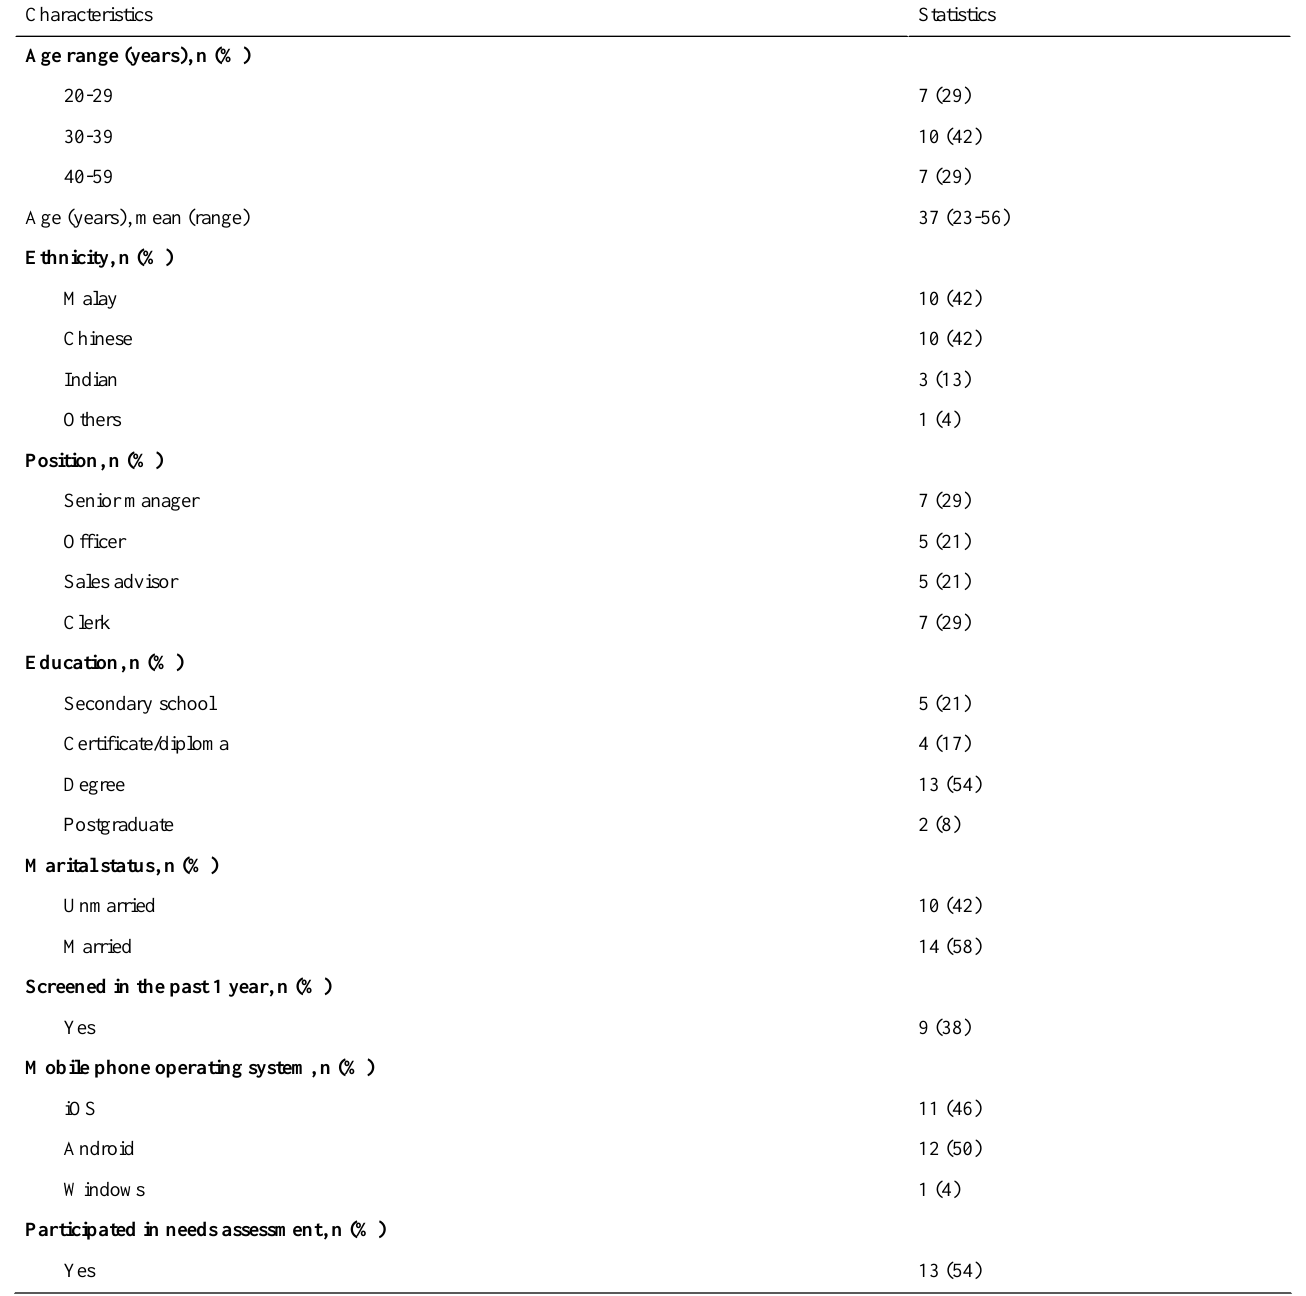
Table 2. Characteristics of participants in the beta testing (N=24).